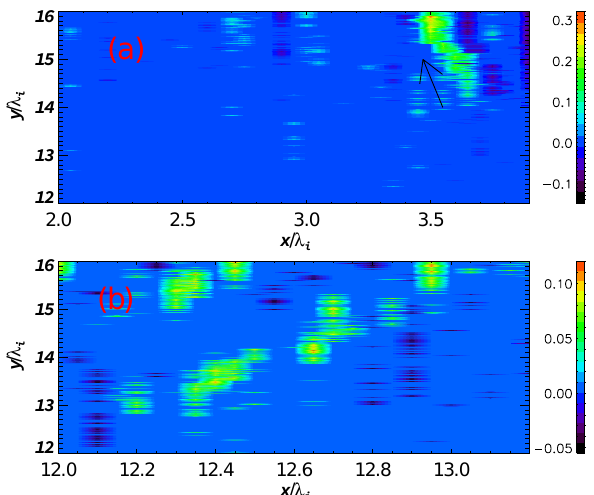
Figure 3. The wave spectrum of parallel electric field. The sampling region is 0 <x/λ i < 6.4 and the time interval is 15.0 <t(cid:127) i < 15.5. broad peak centered around v e // /V A ∼ 10.0 (the flat-top dis-